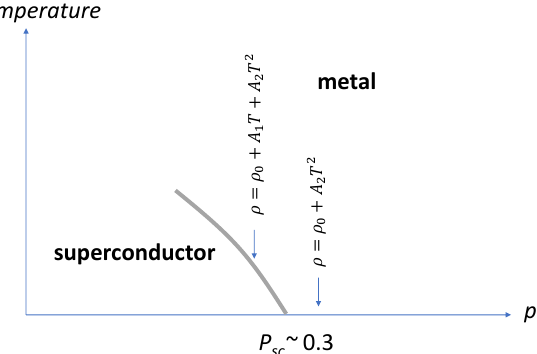
Figure 1: The puzzle: Zoom on the cuprate phase diagram near the end of the su- perconducting dome. Hussey and his co-workers [ 7 ] found that below a threshold doping level, the system has a superconducting ground state and a resistivity which + A T + A T 2 . Above this threshold, the system is not a superconduc- follows ρ = ρ 0 1 2 tor and resistivity can be fit with a purely quadratic temperature-dependnet term: ρ = ρ + A T 2 0 2